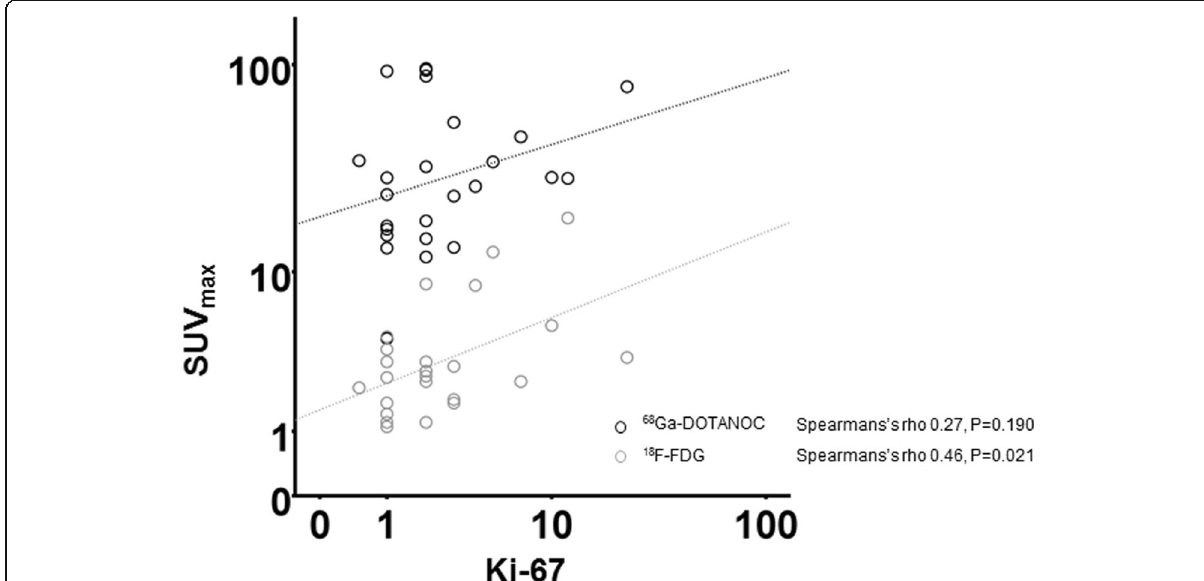
Fig. 3 Logarithm variation of the relationship between the tumor Ki-67 and uptake of 68 Ga-DOTANOC (black circles) and 18 F-FDG (grey circles) for every